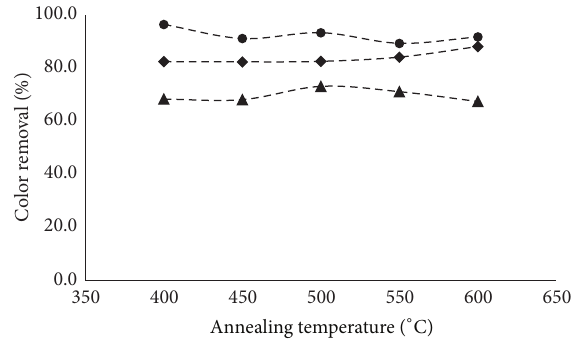
Figure 6: Influence of catalyst thermal treatment on AG50 degra- dation at 40 min reaction and pH 2 using 100 mgL −1 of catalyst containing 37.4 mg/g Fe 2 O 3 : ( 󳵳 ) F, ( X ) F-Us, and ( e ) F-Us-UV.